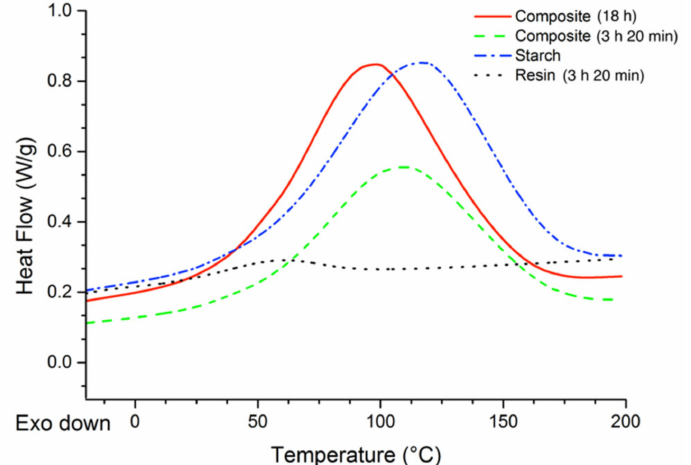
Figure 4. DSC curves of neat starch, unreinforced resin, and starch composites with composition 8, cured at 140 ◦ C for 3 h 20 min, and 18